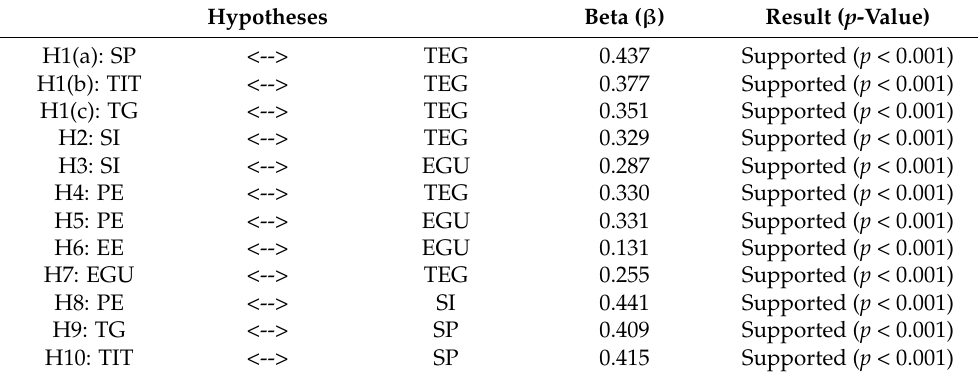
Table 4. Hypotheses testing results.